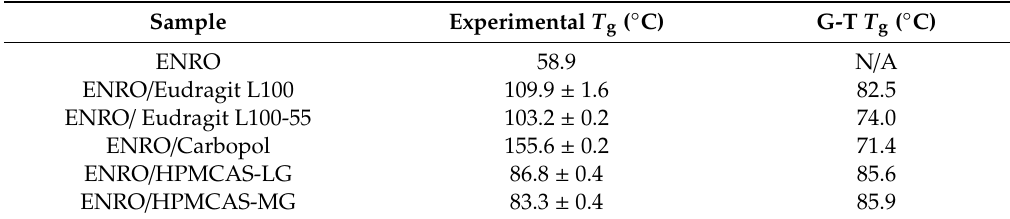
Table 1. Glass transition temperatures ( T g ) of ENRO and ENRO